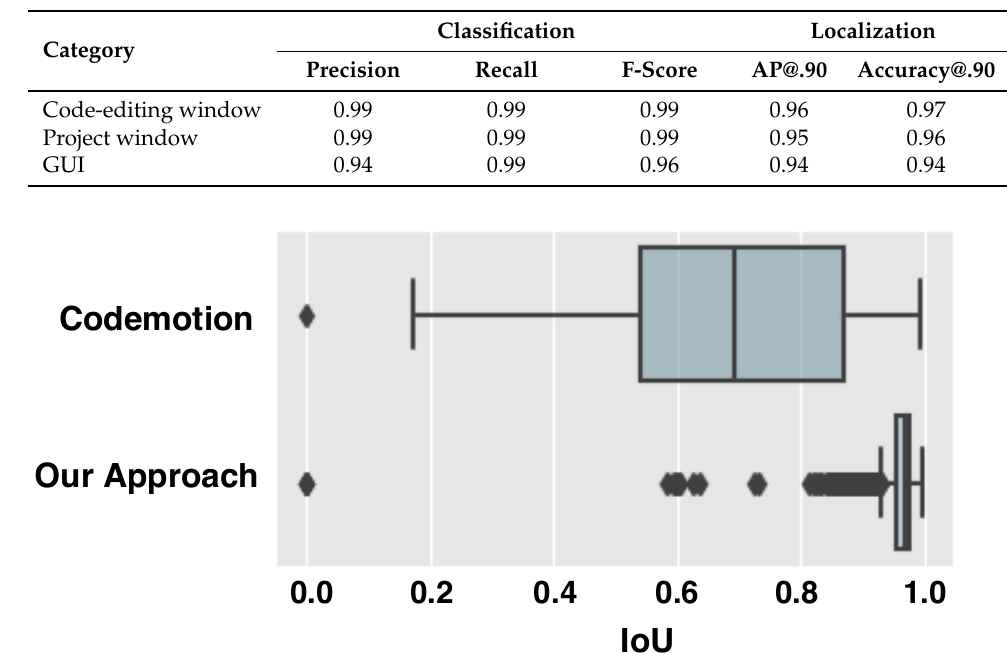
Figure 2. Boxplots of the IoU obtained by applying the Codemotion [5] approach and the approach to detect the code